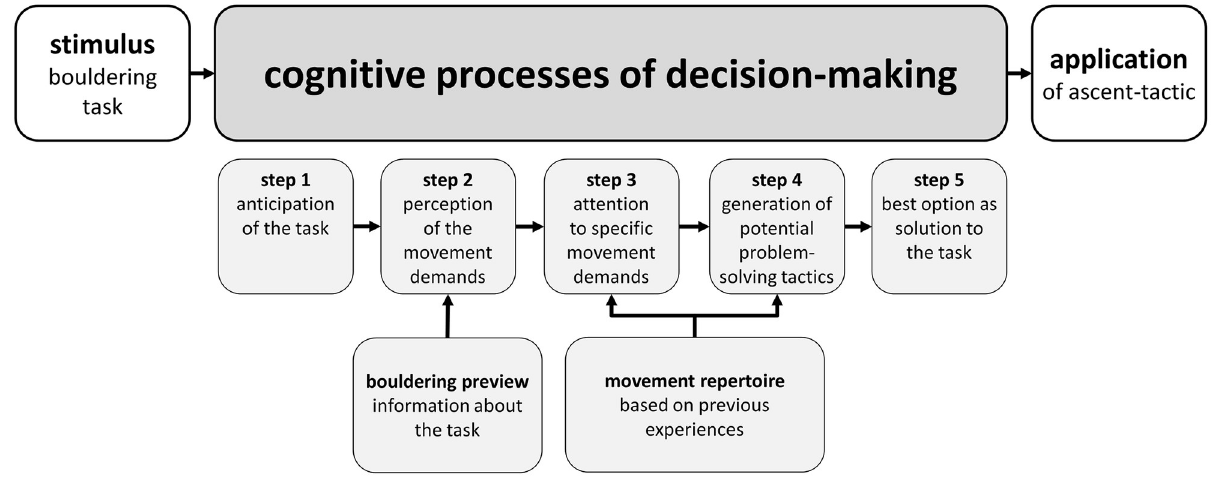
Fig 1. The model of cognitive decision-making processes in indoor bouldering (retrieved and adapted from Memmert [20]).